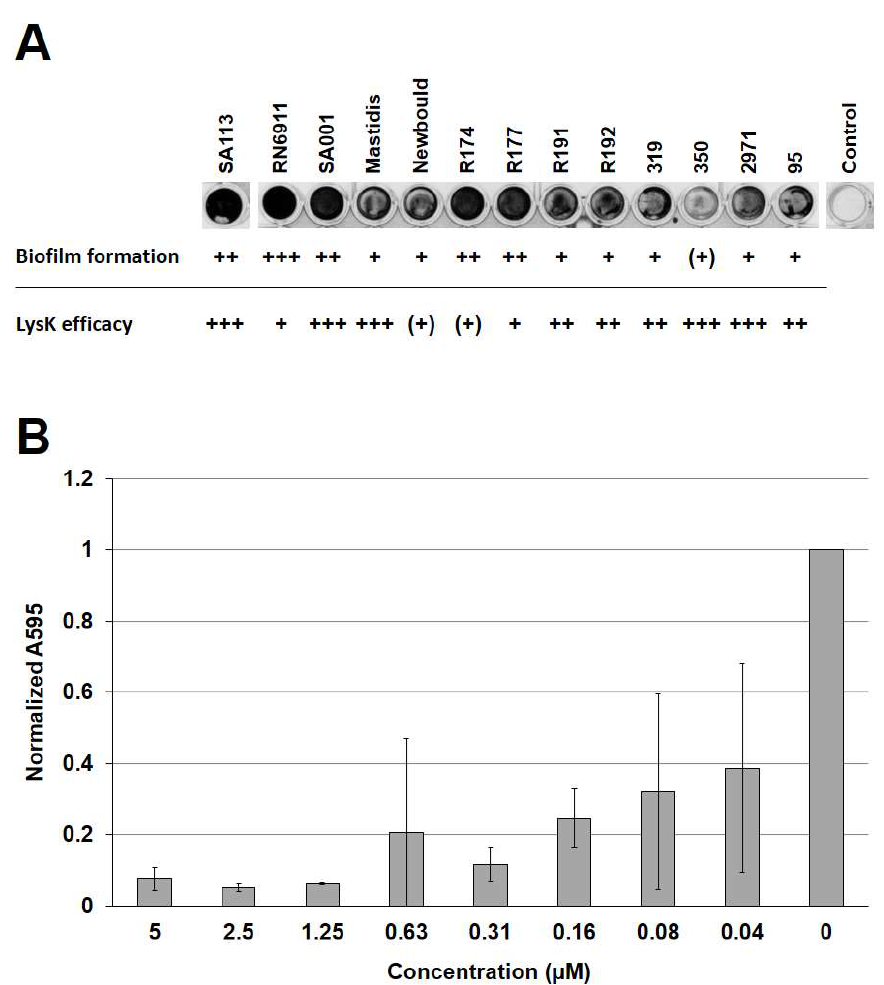
Figure 1. Activity of LysK against biofilms of various S. aureus strains in a static model. ( A ) Biofilm formation and susceptibility to LysK treatment of various S. aureus strains. Biofilms were grown statically in 96-well plates for 24 h at 30 ◦ C and stained with CV. The strains were rated for their biofilm forming ability based on A 595nm measurements of solubilized CV as follows: +++, very strong (A 595nm > 3); ++, strong (A 595nm > 1); +, moderate (A 595nm > 0.2); (+), weak (A 595nm ≤ 0.2). At least three experiments were conducted, and one representative well for each strain is shown ( top ). Efficacy of LysK against biofilms of each strain was determined as exemplified for SA113 in ( B ) and rated as follows ( bottom ): +++, > 40% reduction in A 595nm compared to the control at a concentration (c) ≤ 0.08 µ M; ++, > 40% reduction at c ≤ 0.31 µ M; +, > 40% reduction at c ≤ 1.25 µ M; (+), no reduction > 40% even at c > 1.25 µ M. ( B ) S. aureus SA113 biofilms grown in a 96-well plate for 24 h at 30 ◦ C were treated with LysK at different concentrations or buffer as a control (0) for 2.5 h, and residual biofilms after treatment were stained with crystal violet (CV). After dissolving the CV in 96% ethanol, the A 595nm of each well was measured spectrophotometrically. All values were normalized to the control. Error bars indicate standard deviations from three independent experiments.